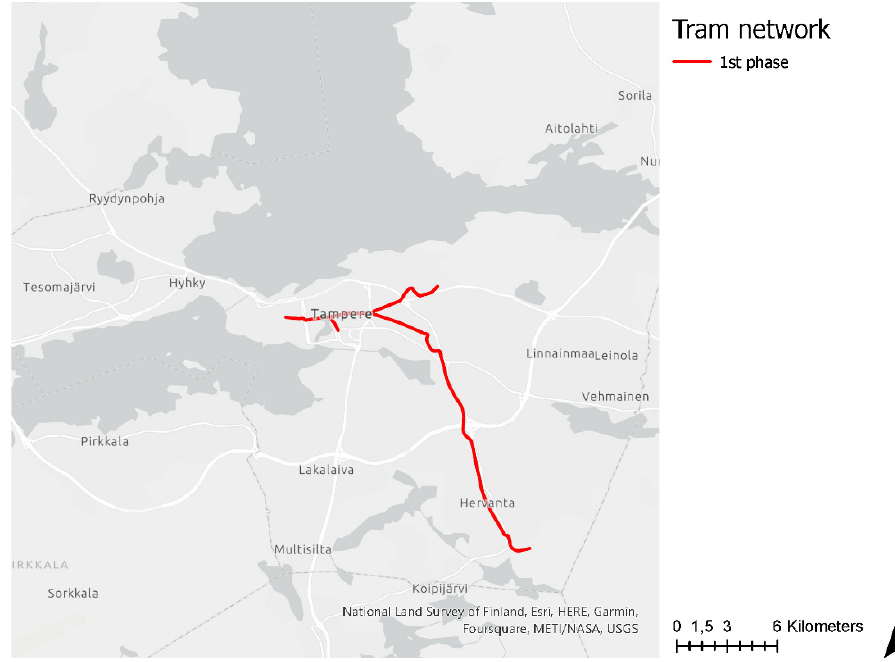
Figure 1. Developed tram network in Tampere Finland.